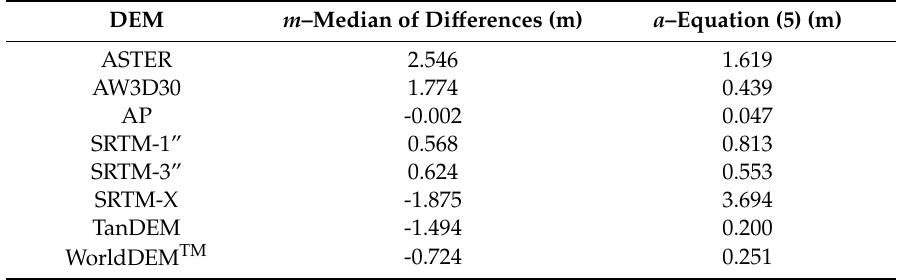
Table 4. Parameters of the Laplace probability distribution function estimated using the maximum likelihood estimator from the discrepancies between the investigated DEMs and the reference elevations.